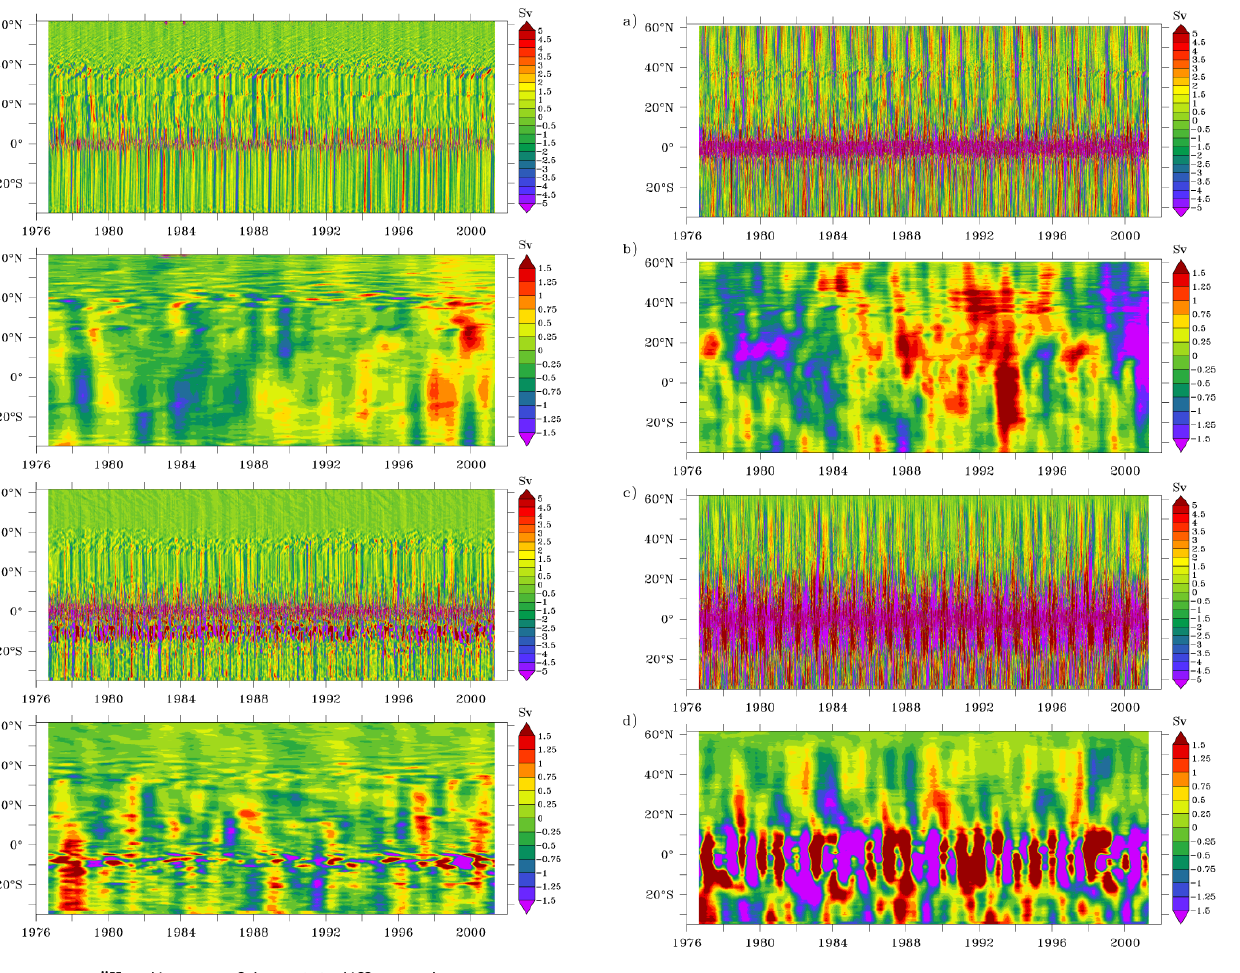
Fig. 18. Hovm¨oller diagram for MOC-Ekman transport at 1000m depth for experiment B025. (a) , (b) Atlantic MOC on subannual (a) and interannual (b) timescales. (c) , (d) As (a) , (b) for